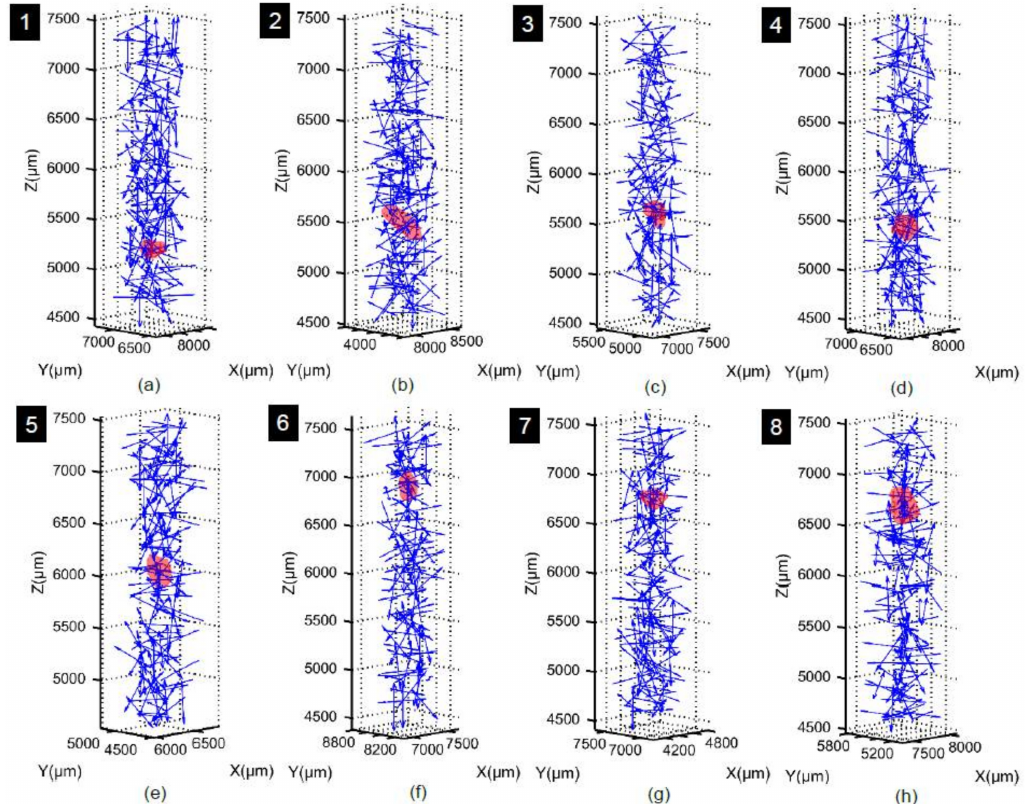
Figure 22. Contact normal vectors within selected regions of interest around particles at vertical stress of 8 MPa (numbers with black background represent the particle IDs of Figure 18; red regions represent the particles’ positions).